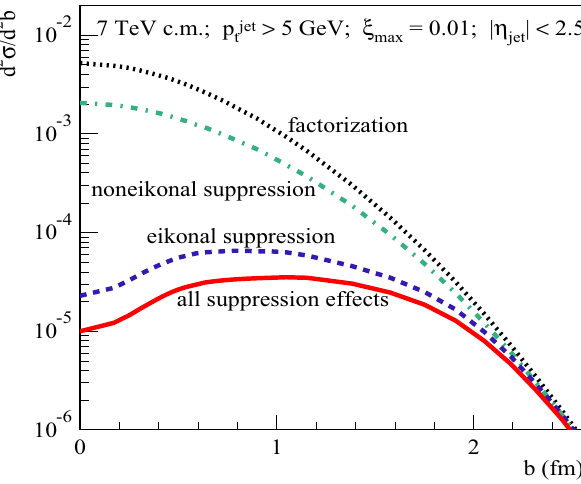
Fig. 11 Left: transverse profiles for SD dijet production − SD ( fact ) / d 2 b , calculated based on the factorization assump- d 2 σ 2jet pp tion, for p cut t = 5 and 50 GeV/c (dashed and dotted-dashed lines, respectively), compared to the inelastic profile (solid line). Right: transverse profiles for SD dijet production for p cut t = 5 GeV/c,